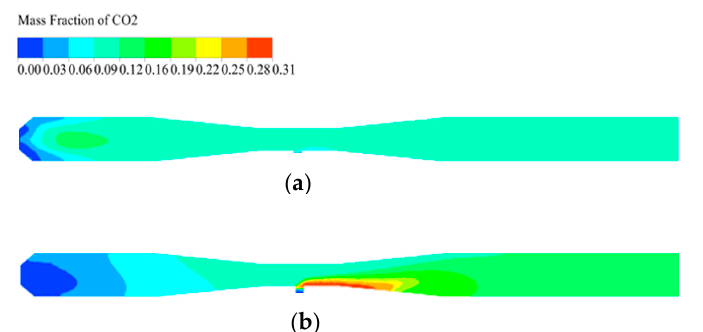
Figure 6. Distribution nephogram of CO 2 concentration field: ( a ) without the addition of citric acid and ( b ) with the addition of citric acid.